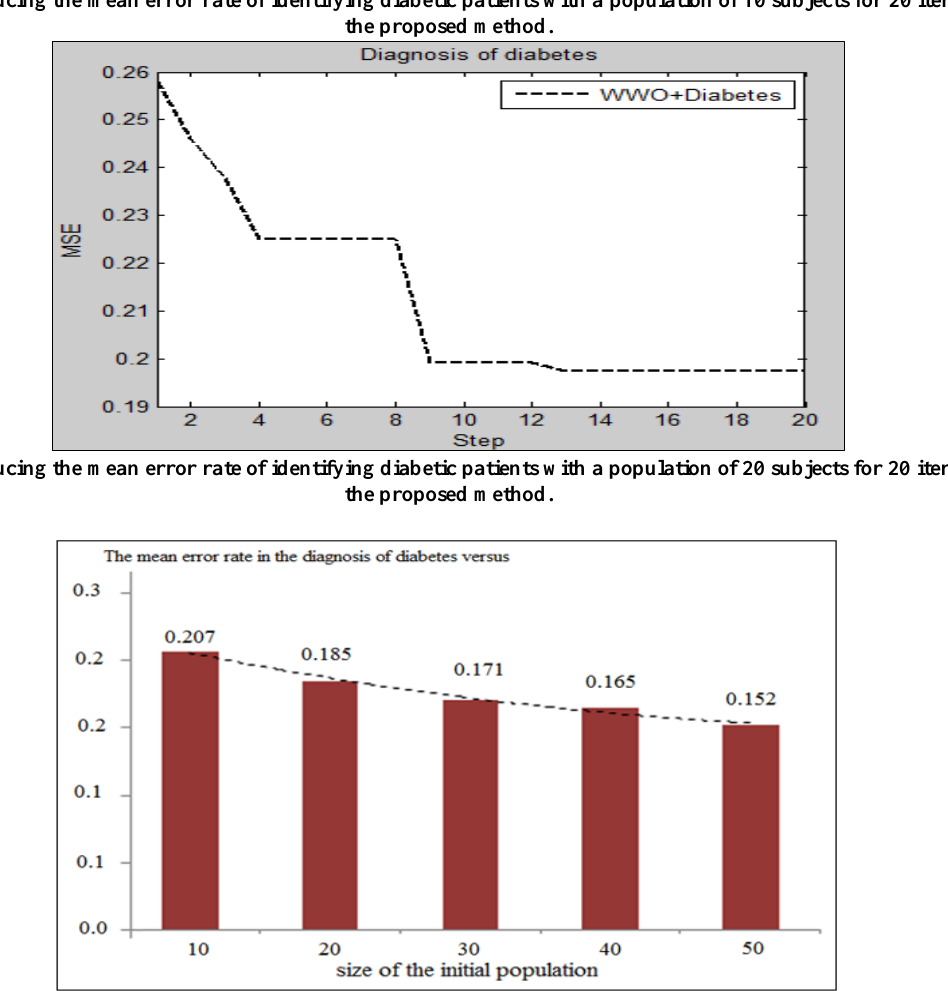
Figure 10. The mean error rate in the diagnosis of diabetes versus the size of the initial population of water